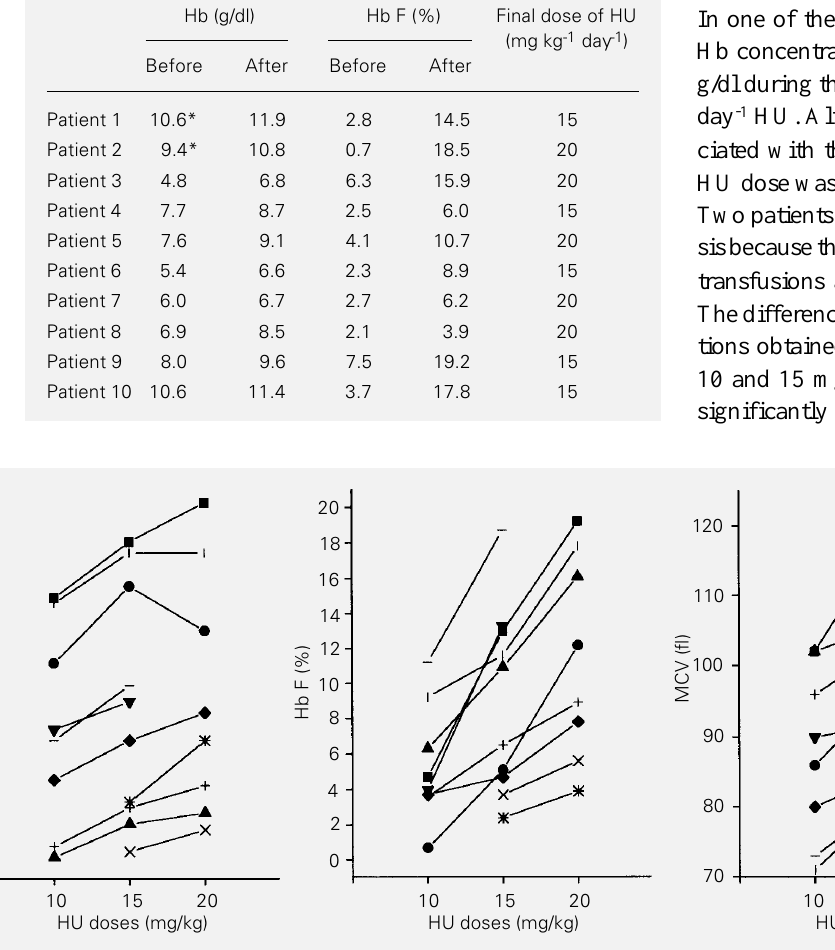
Table 2 - Hemoglobin (Hb (g/dl)) and fetal hemoglobin (Hb F (%)) before and after hydroxyurea (HU) administration. Final doses of HU are also shown. *Cerebral vascular accident in transfusion.